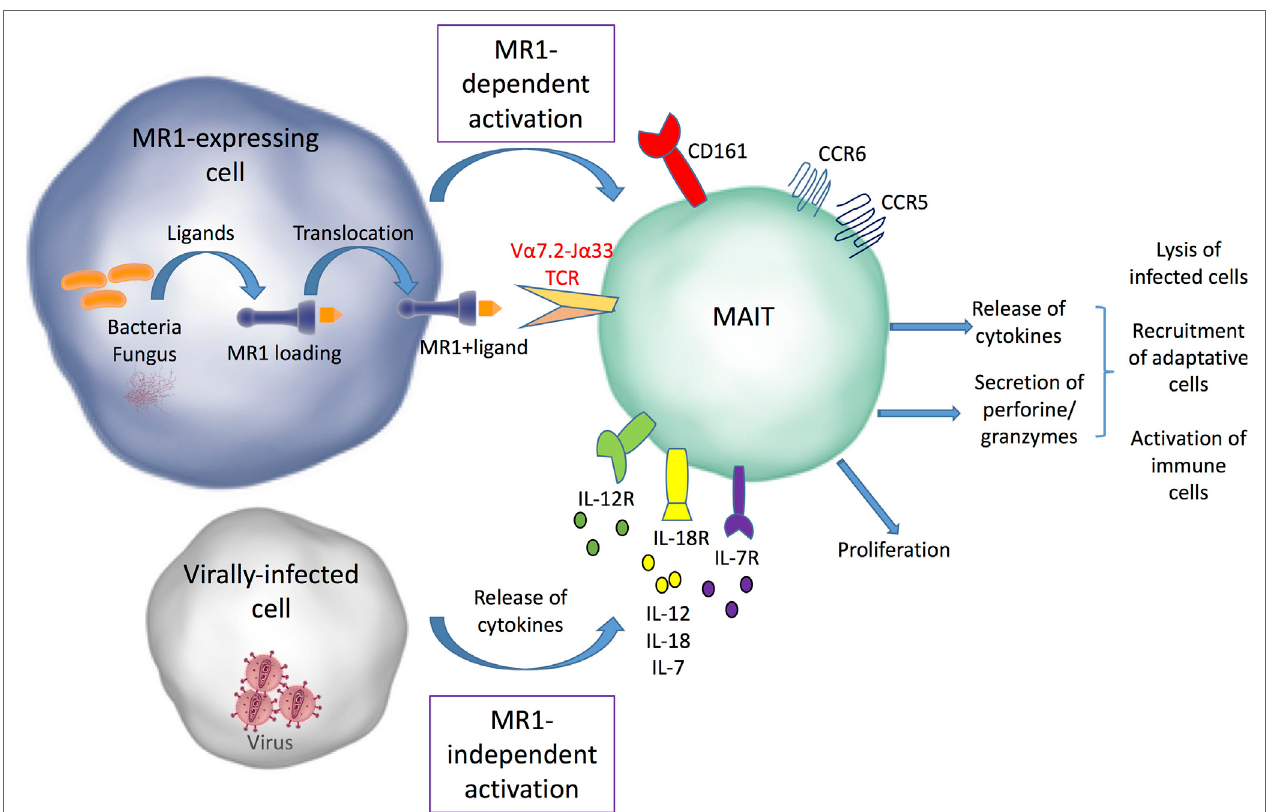
FigURe 1 | MR1-dependent and independent mucosal-associated invariant T (MAIT) cell activation. Bacterial and fungal ligands can be presented by MR1 to MAIT cells and induce their activation. MAIT cells can also be activated independently from MR1 by different types of cytokines secreted by infected cells. After their activation, MAIT cells proliferate and release cytokines and cytolytic enzymes, which allow infected cell lysis and promote the recruitment and activation of other immune